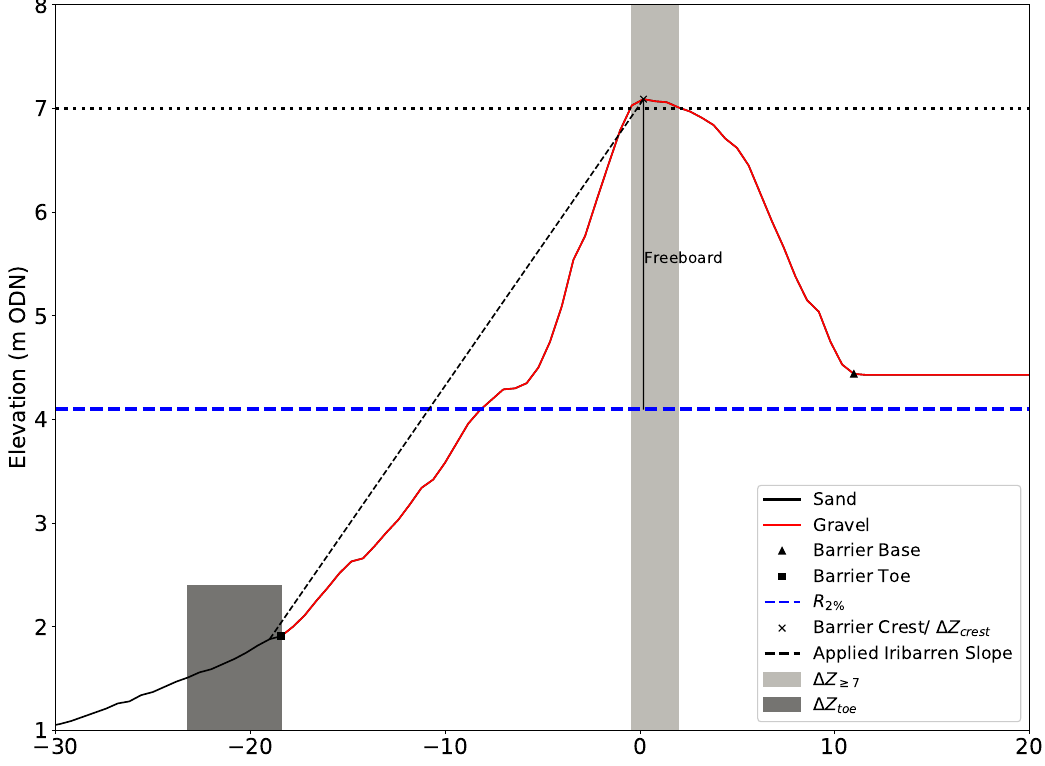
Figure 6. A schematic of proxies used to describe the results of the XBeach-X